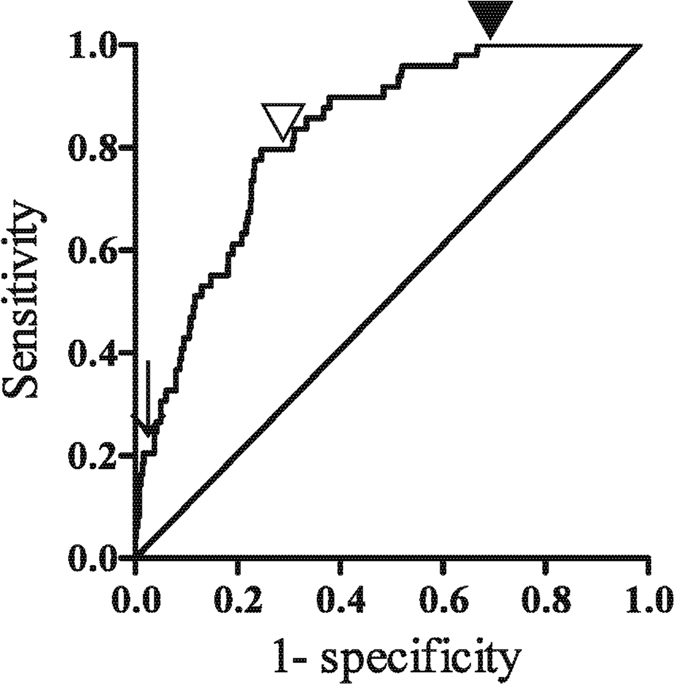
Receiver operating characteristic (ROC) curve for predicting incidence of macroalbuminuria unrelated to non-diabetic renal events by measurement of ACR.ROC was performed for baseline ACR. The area under the curve for ACR was 0.8249. Setting the ACR cut-off at 7.5 mg/gCr (▼) resulted in a sensitivity of 100% and a specificity of 31%. Setting the ACR cut-off at 30 mg/gCr (▽) resulted in a sensitivity of 80% and a specificity of 72%. Setting the ACR cutoff at 150 mg/gCr (↓) resulted in a sensitivity of 20% and a specificity of 98%.